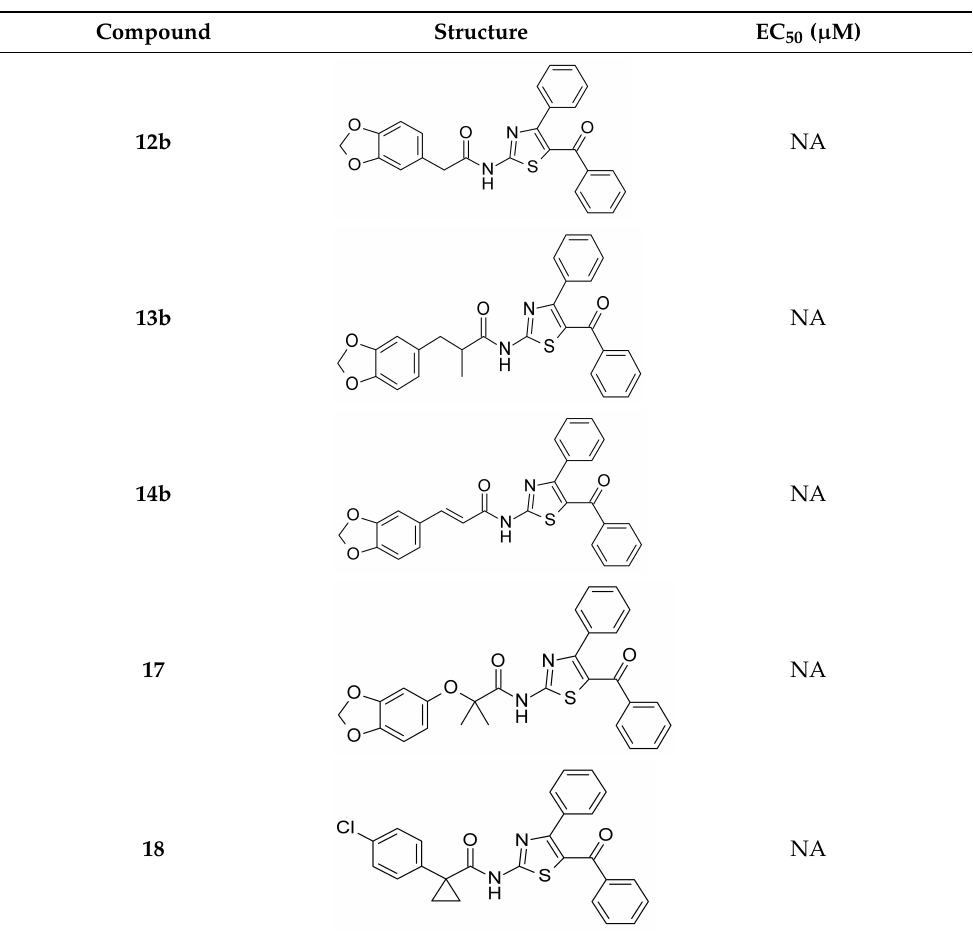
Table 1. Chemical structure and potency trend of the new hybrids 12b, 13b, 14b, 17, and 18 as F508del CFTR